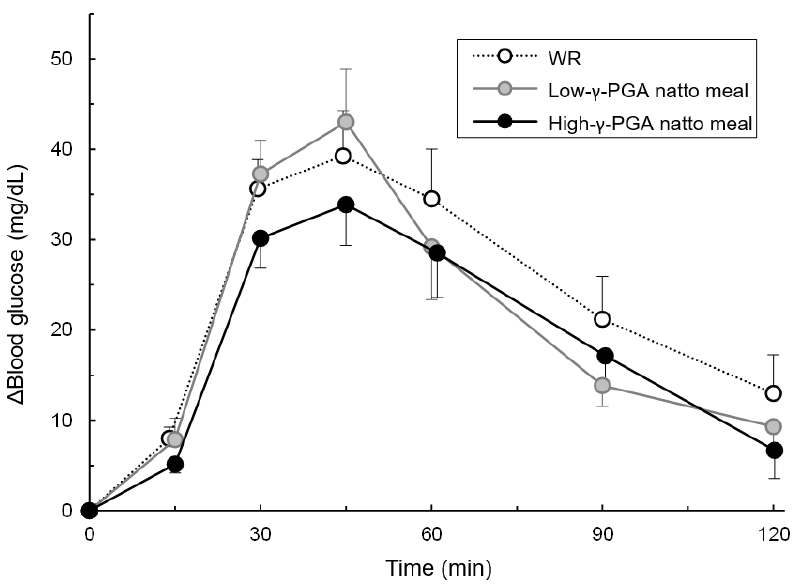
Figure 4. Changes in blood glucose levels over time following each test meal loading. The blood glucose elevation data from fasting to 15, 30, 45, 60, 90, and 120 min are shown as the mean ± the standard error (SE). WR: white rice; γ-PGA: gamma-polyglutamic acid.